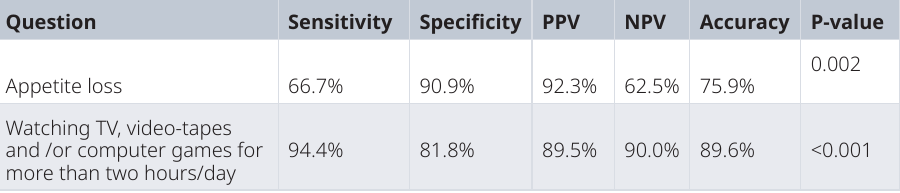
Table 10. Development of the valid and simple nutritional screening tool during the late childhood